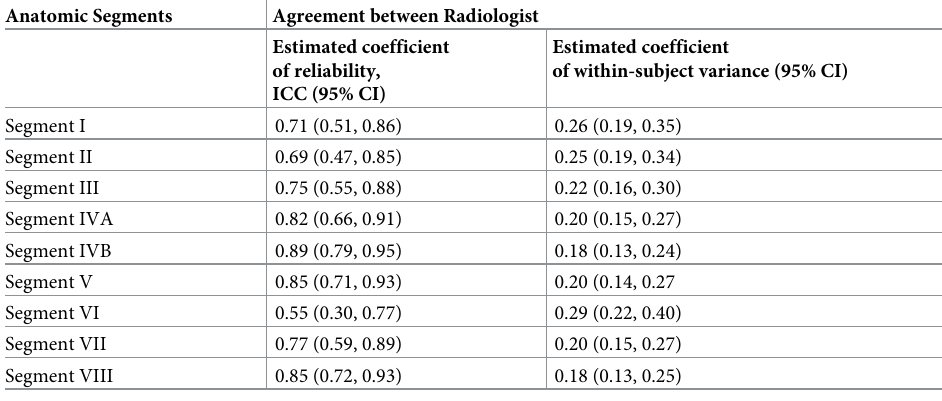
Table 3. Interclass correlation coefficient for MRI reading by two independent readers.